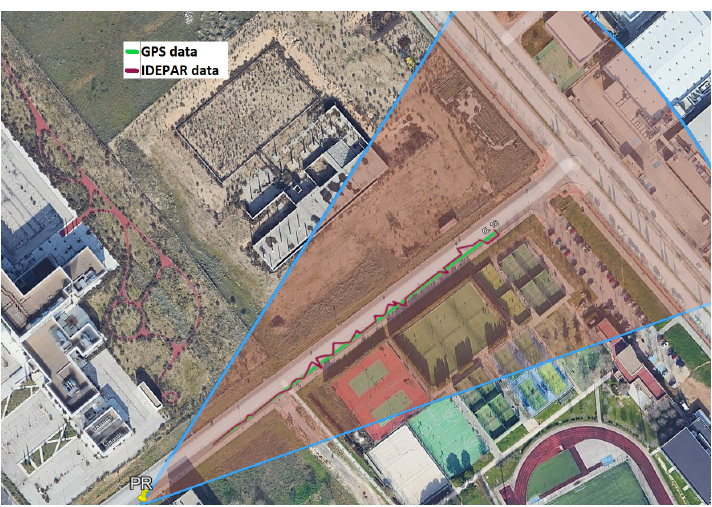
Figure 20. Estimated target trajectory with T int = 500 ms versus GPS data in geographical